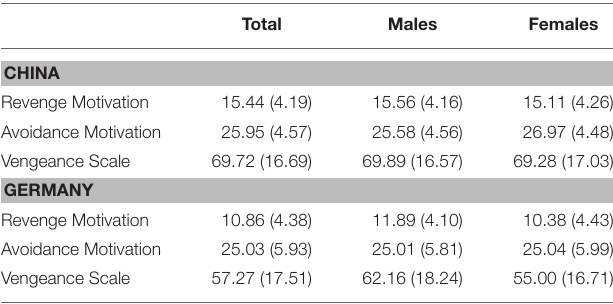
TABLE 2 | Descriptive statistics of all scales under investigation split by nation and